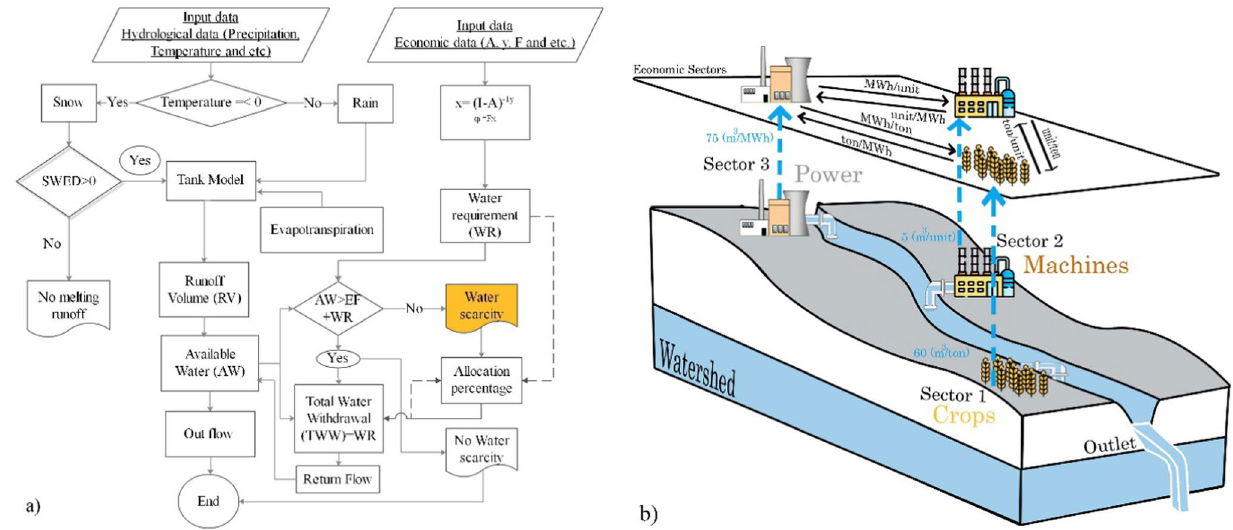
Fig. 3 The coupled model algorithm ( a ) and the location of economic sectors in the watershed ( b ). Note that the water balance is made at the outlet and that all flows are treated as if they are either added to or withdrawn from this